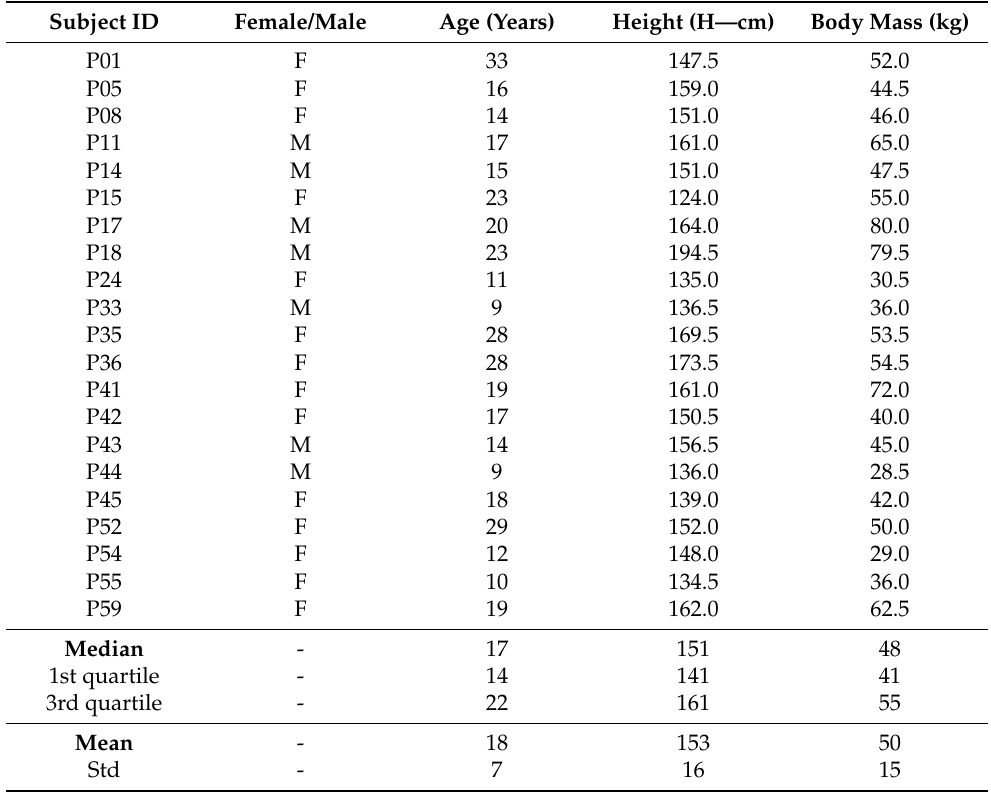
Table 1. Demographic and clinical characteristics of the included DS subjects.